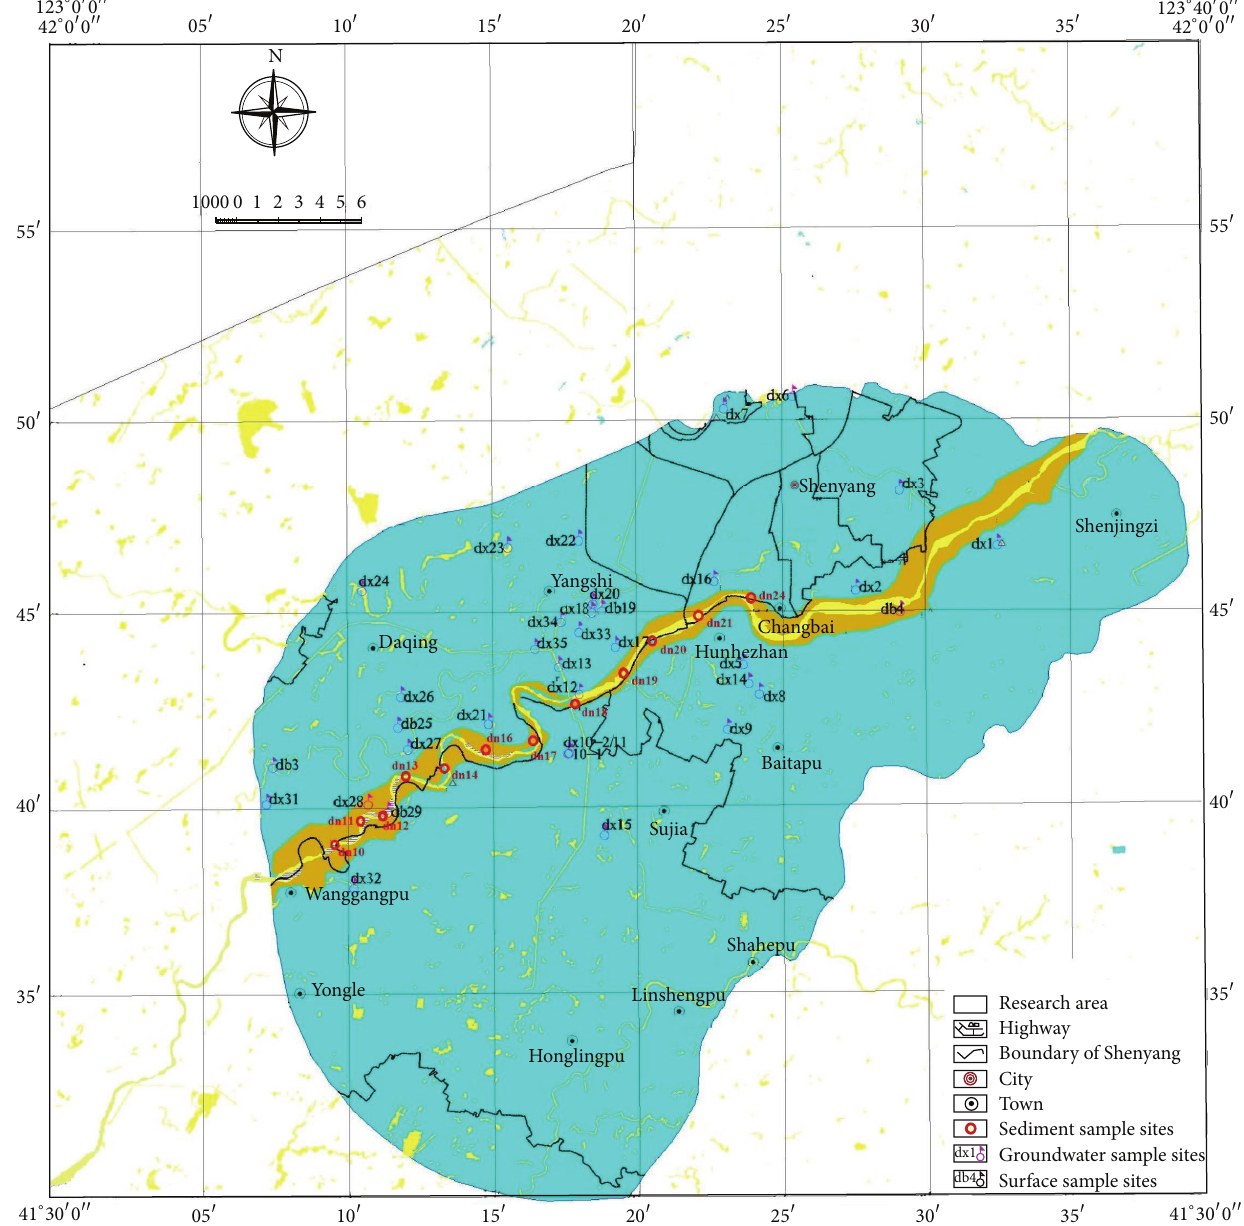
Figure 1: The distribution of the groundwater and sediment sampling